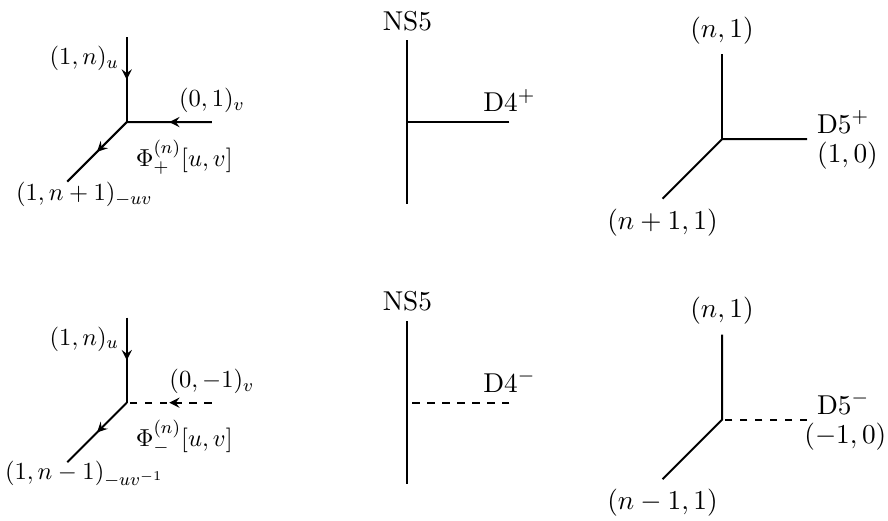
Figure 4 . Correspondences of the positive and negative intertwiners with brane junctions of type IIA and type IIB theory. Dual intertwiners have similar physical